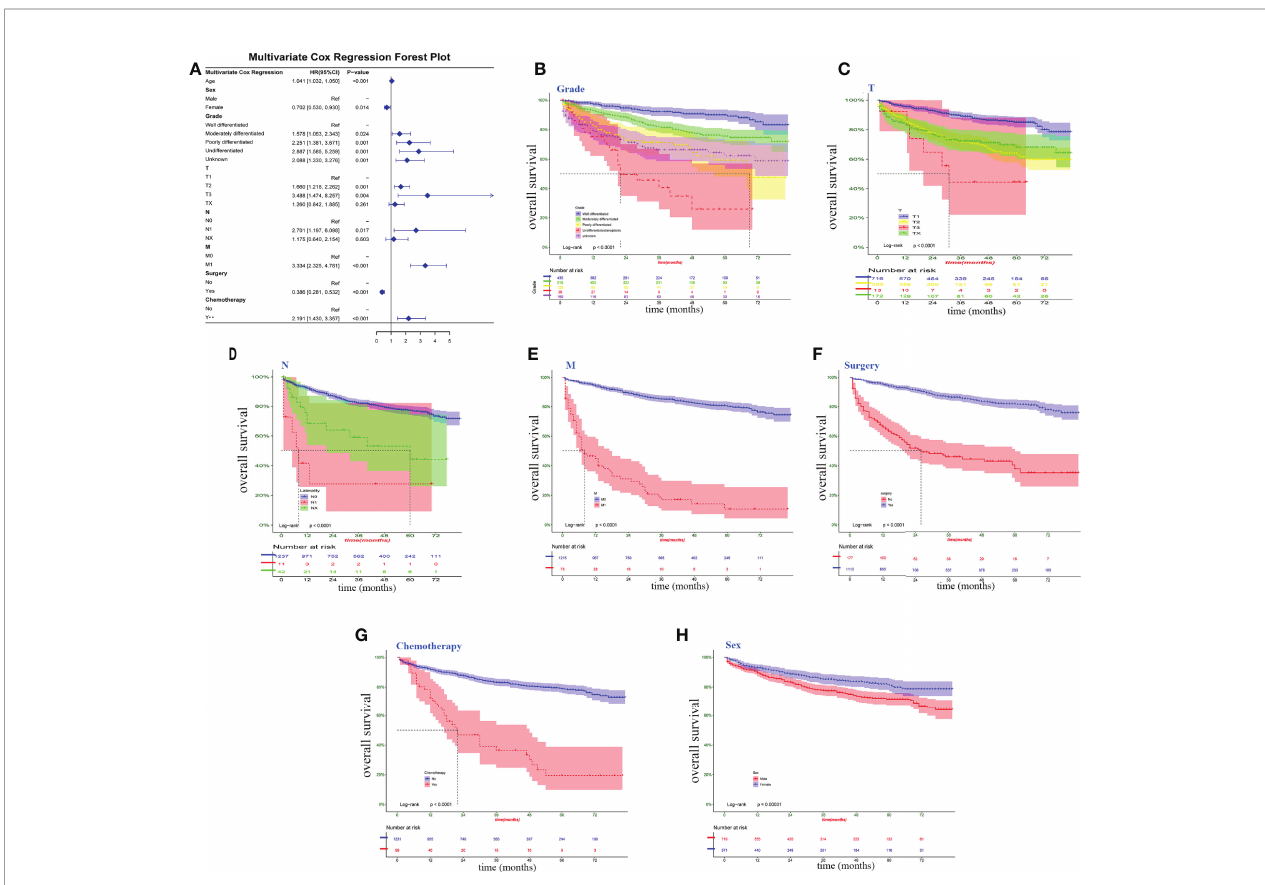
FIGURE 2 | Clinical factors associated with survival risk. (A) multivariate Cox forest plot for the variables on Surveillance, Epidemiology and End Results data. (B – H) Kaplan – Meier survival curve; log-rank tests were performed for categorical variables. P < 0.05, signi fi